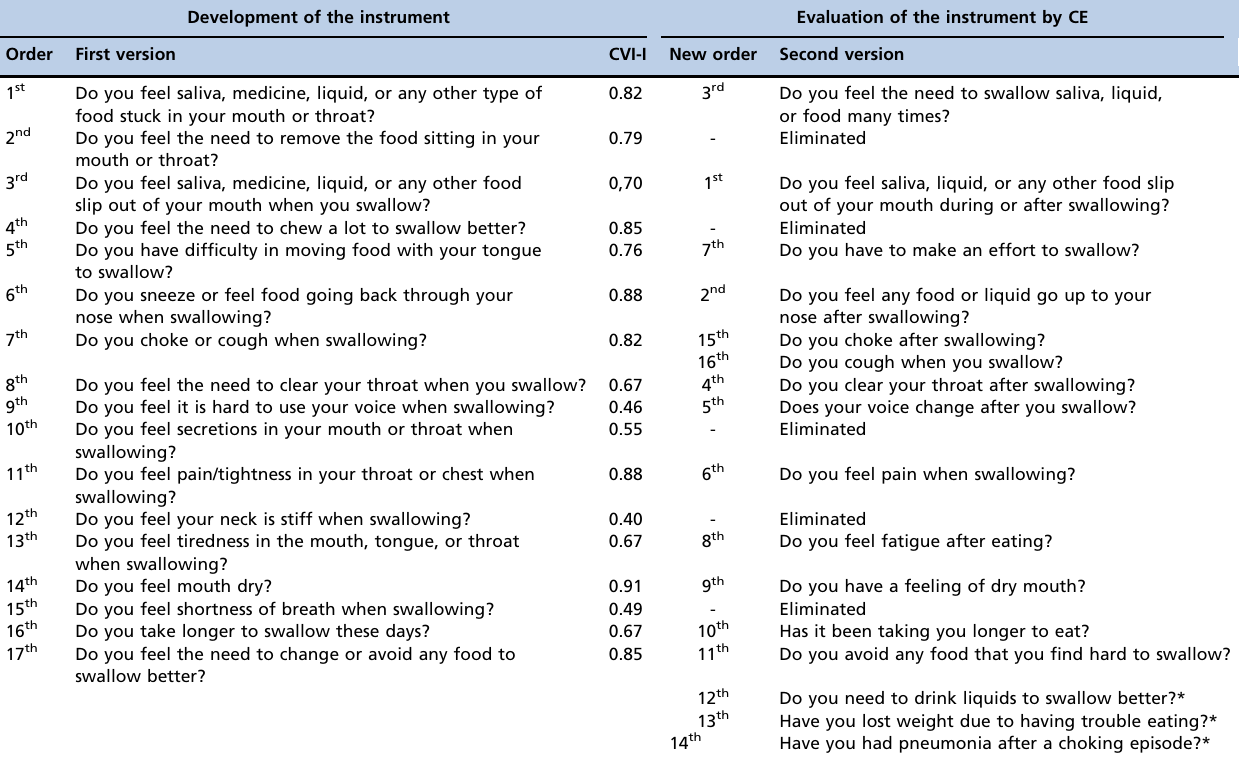
Table 3 - Validity evidence based on the test